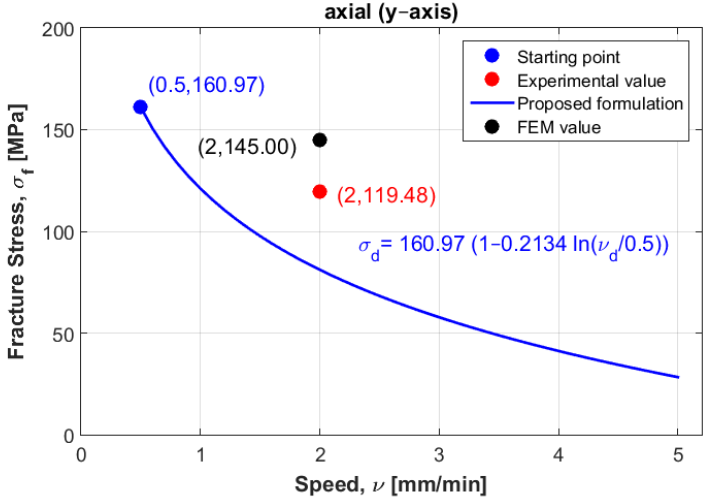
Figure 10. Curve modeling for the radial direction and the experimental point at the second displacement rate.